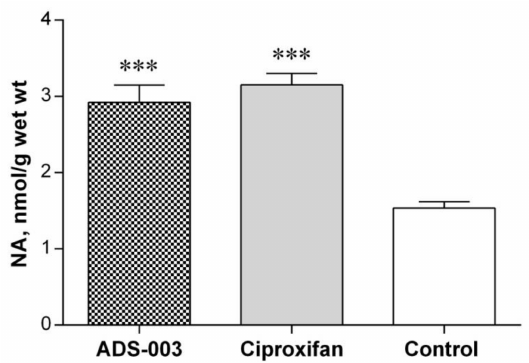
Figure 4. The concentration of noradrenaline (NA) in the cerebral cortex of rats subchronically treated with the newly synthesized ADS-003 histamine H 3 receptor antagonist or with Ciproxifan. The values are means ± SEM for four–nine rats. One-way ANOVA and Tukey’s multiple: *** p < 0.05, three symbols: p <